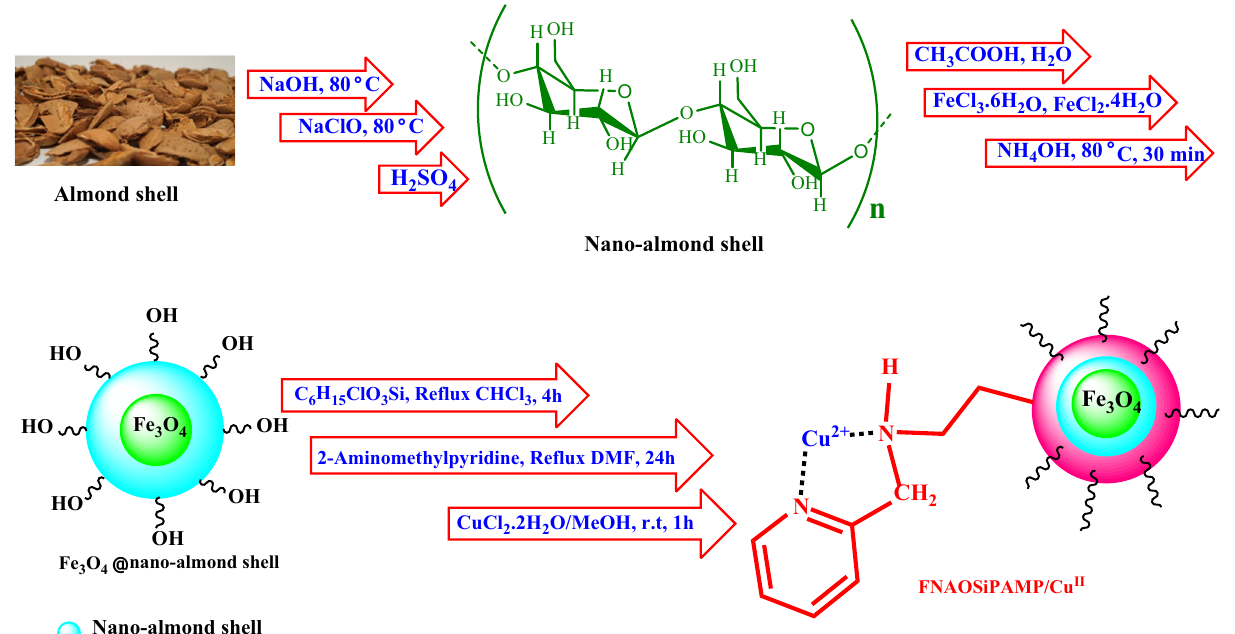
Figure 1. Graphical representation of FNAOSiPAMP/Cu II synthesis.